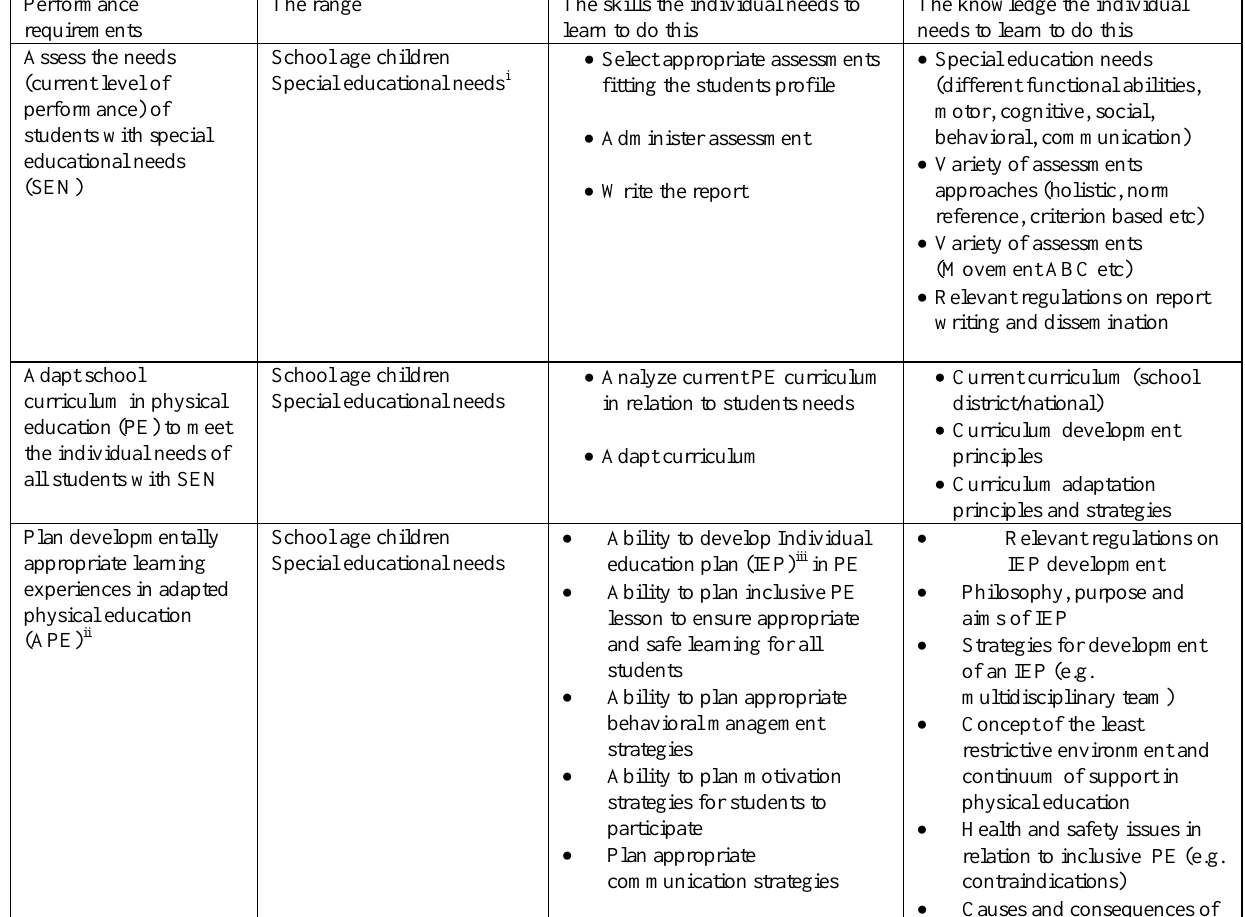
Table 3. Knowledge, Competence and Skills Framework in Adapted Physical